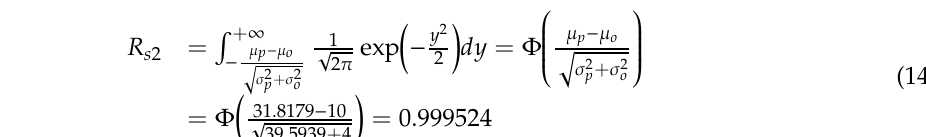
Figure 5. Distribution of ( a ) compressive stress and ( b ) contact stress.